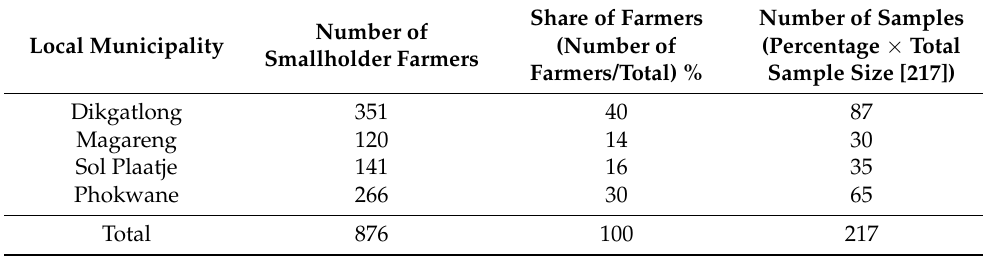
Table 1. Number of farmers who received assistance from the government and sampling